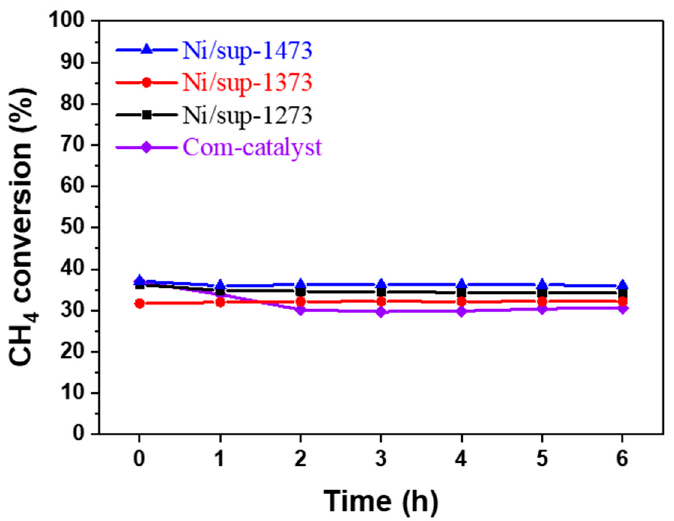
Figure 9. The methane conversion of Com-catalyst (purple line), Ni/sup-1273 (black line), Ni/sup-1373 (red line) and Ni/sup-1473 (blue line) after the SMR reaction under harsh conditions.